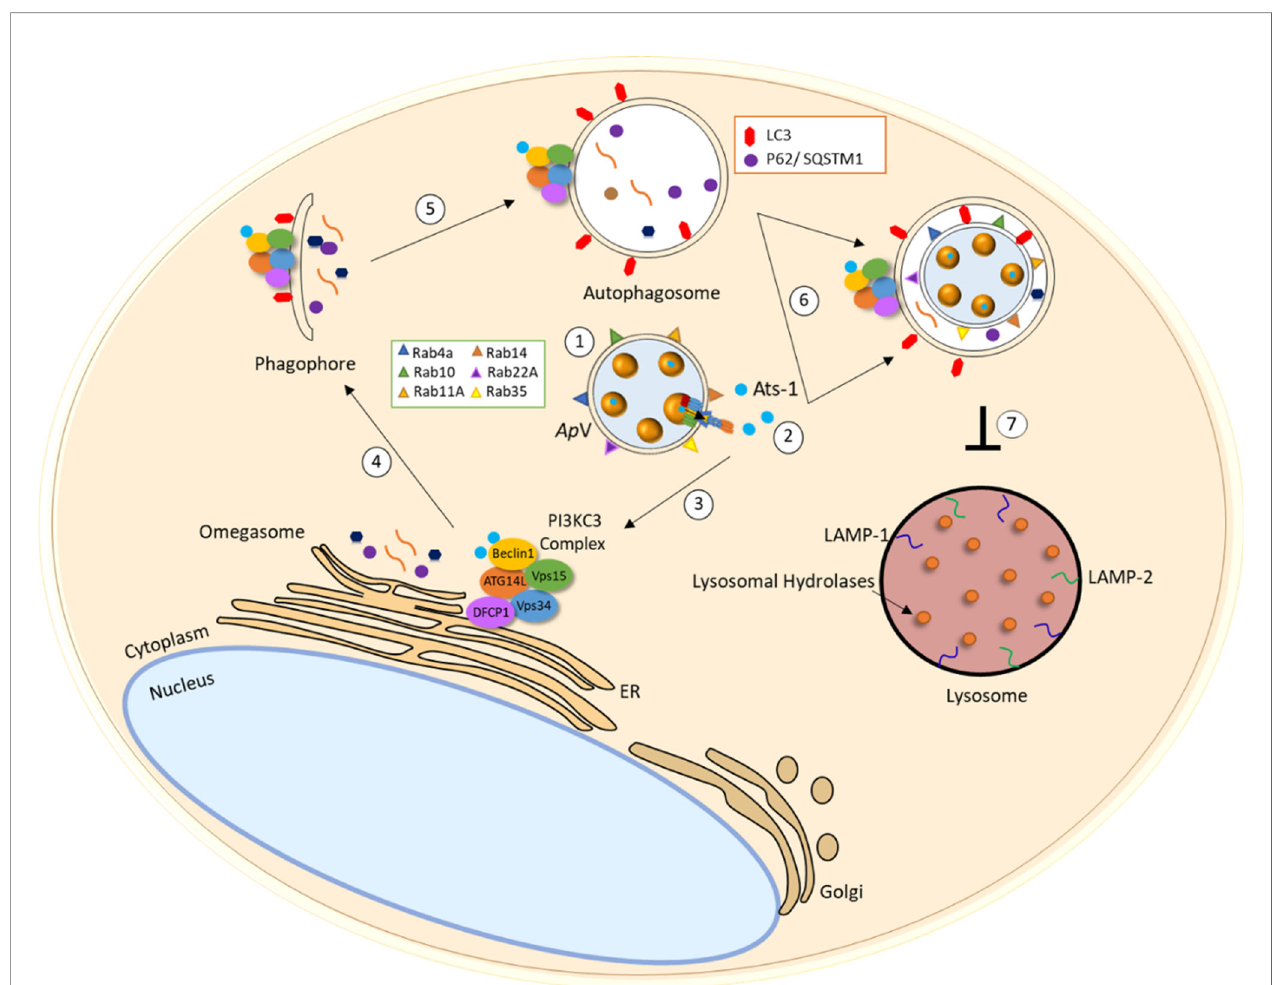
FIGURE 1 | A. phagocytophilum interplay with the autophagic pathway. (1) A. phagocytophilum selectively recruits Rab GTPases Rab4A, Rab10, Rab11A, Rab14, Rab22A, Rab35 which regulate endocytic recycling and Rab1 which regulates vesicular protein transport from the endoplasmic reticulum (ER) to the Golgi compartment. (2) T4SS effector Ats-1 is translocated from the ApV into the host cell cytoplasm and (3) directly interacts with autophagsome initiation complex (Atg14-Beclin 1-Vps34) to initiate omegasome formation in the ER. (4) Isolation membrane elongates and (5) double-membrane autophagosome decorated with LC3 form. (6) Autophagosomes are recruited to the ApV that fuse to release autophagic body content. (7) A. phagocytopilum blocks lysosomal fusion potentially by preventing endosomal maturation and/or through other unknown